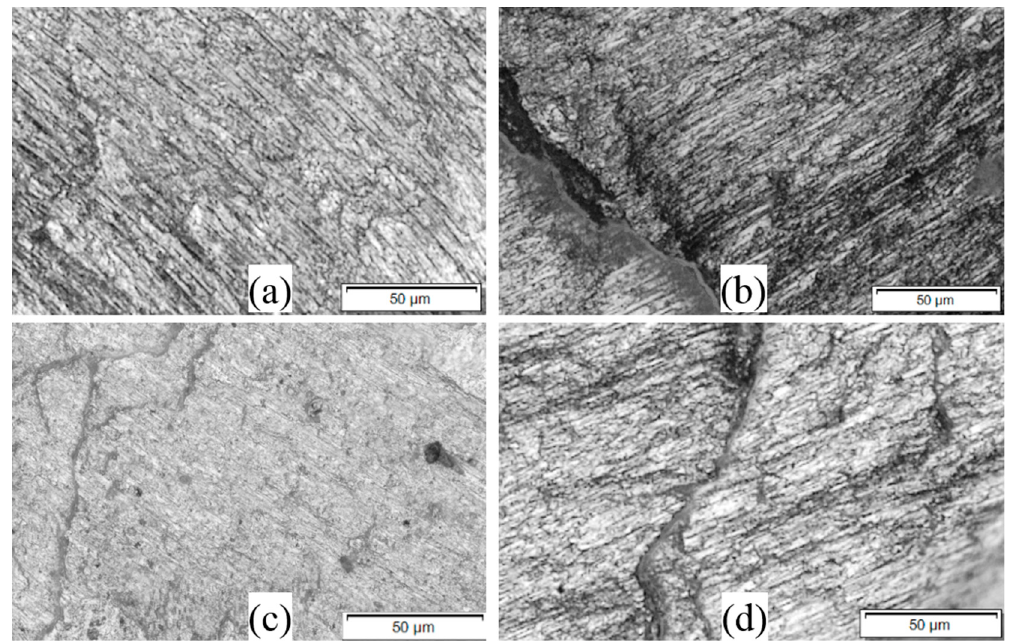
Figure 6. Bottom surfaces of chips in different conditions ( a ) 60 mm/min speed, 0.025 mm/tooth feed; ( b ) 60 mm/min speed, 0.075 mm/tooth feed; ( c ) 140 mm/min speed, 0.025 mm/tooth feed and ( d ) 140 mm/min speed, 0.075 mm/tooth feed.